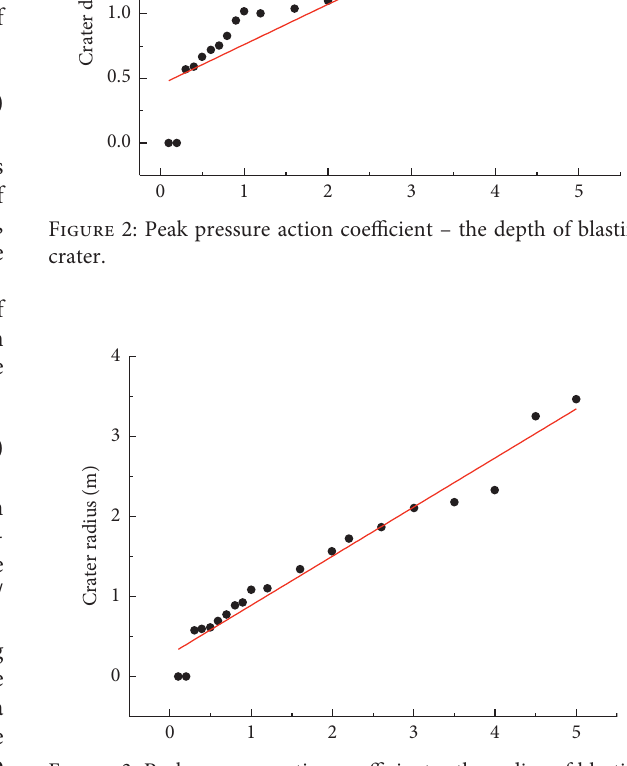
Figure 3: Peak pressure action coefficient – the radius of blasting crater.